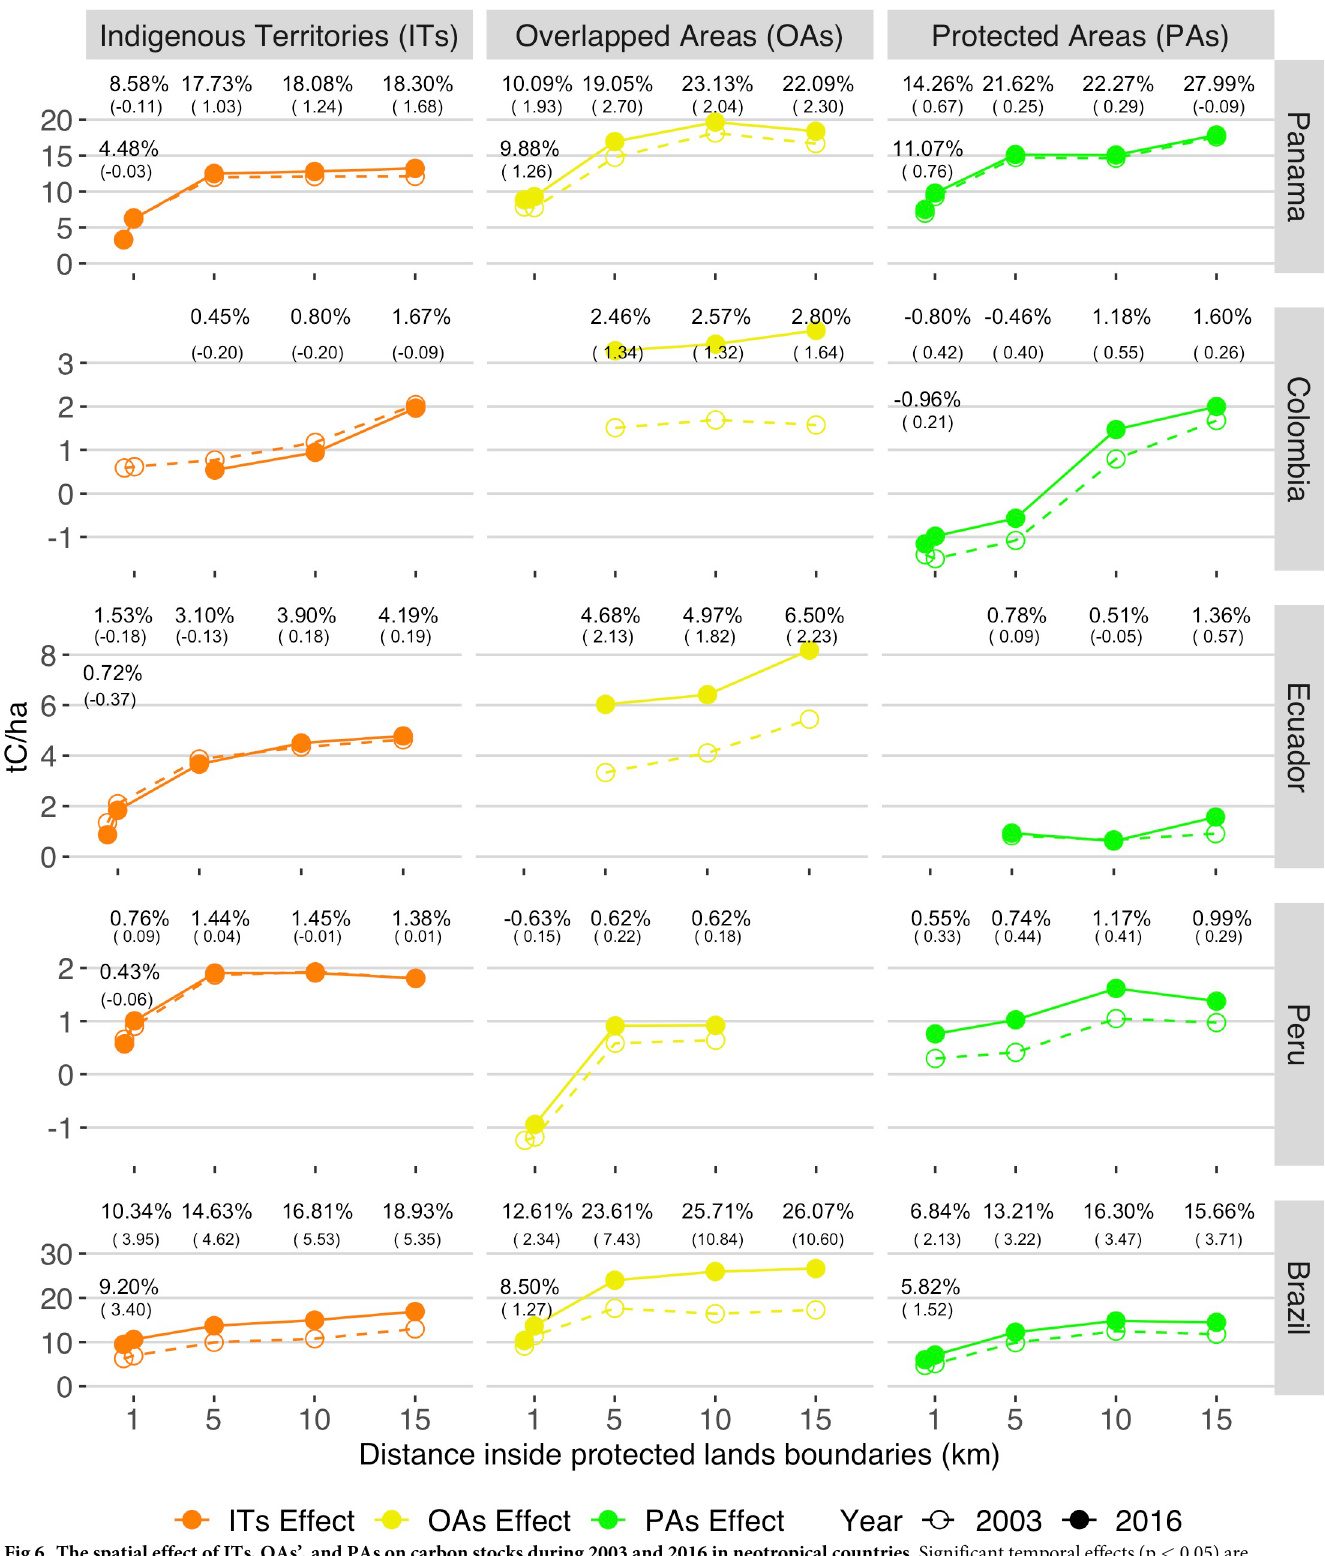
Fig 6. The spatial effect of ITs, OAs’, and PAs on carbon stocks during 2003 and 2016 in neotropical countries. Significant temporal effects (p < 0.05) are represented as points and percentages, indicating the additional/fewer carbon stocks secured inside the boundaries of ITs (orange), OAs (yellow), and PAs